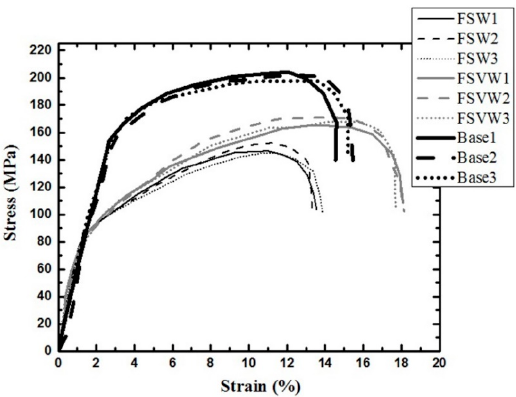
Figure 8. Stress-strain curves of FS- and FSV-welded specimens, as well as the base material. The higher ductility of FSV-welded specimens may also be related to grain size effect in the FSW zone. Various studies have been carried out to determine the effect of grain size on ductility. Some